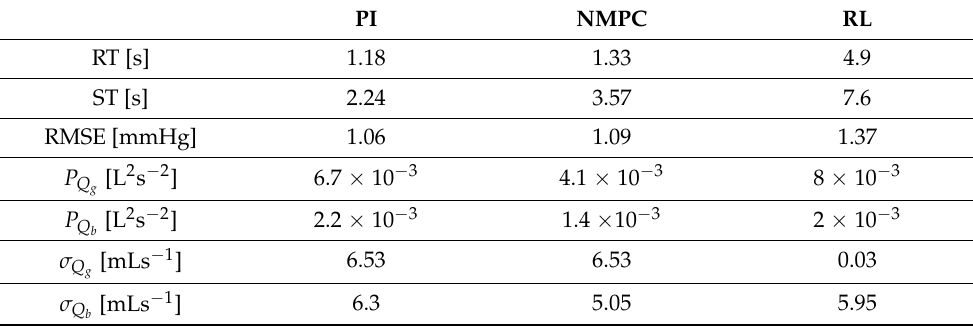
Figure 3. Results of the control experiments. The top row shows setpoints and manipulated variable— p CO for the three controllers. The bottom row shows the actions taken—sweep flow rate (SFR) and blood flow rate (BFR)—by each controller for a snip of the reference tracking task. The disturbance S is also shown. Table 1. Results of the control experiments. The PI, NMPC, and RL controllers were assessed based on rise time (RT), settling time (ST), root-mean-squared error (RMSE), action power P, and action standard deviation σ .